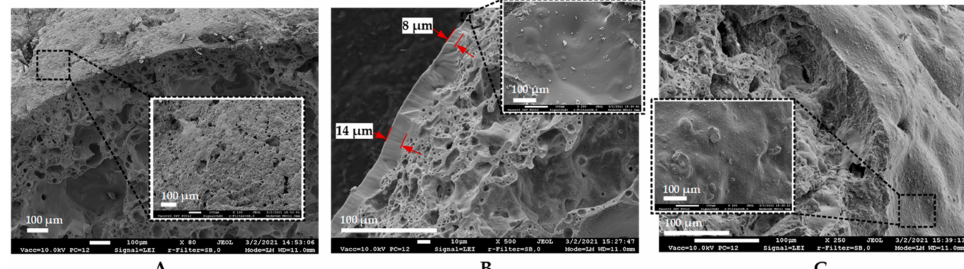
Figure 5. Scanning electron microscopy images of coated bacteria-immobilized expanded clay particles used in this study: ( A ) control sample with no coating and a vast number of open pores at the surface, ( B ) styrene–acrylate and ( C ) MgO-based coated samples with blocked pores. The variation of the thickness of a styrene–acrylate protective layer is indicated in ( B